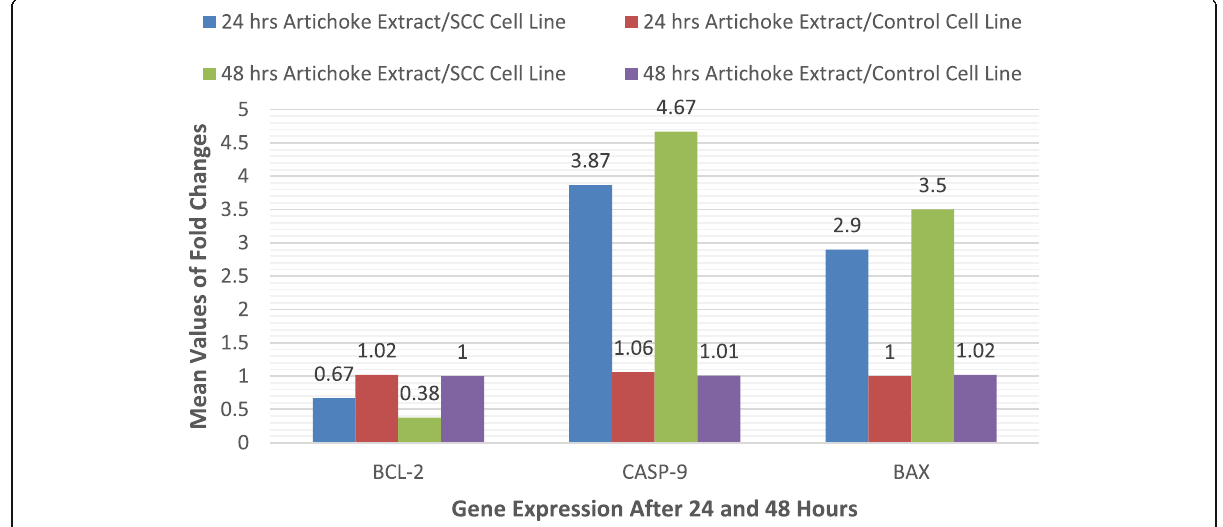
Fig. 1 Mean values of fold changes in gene expression occurred in studied control and SCC-25 cell lines after 24 and 48